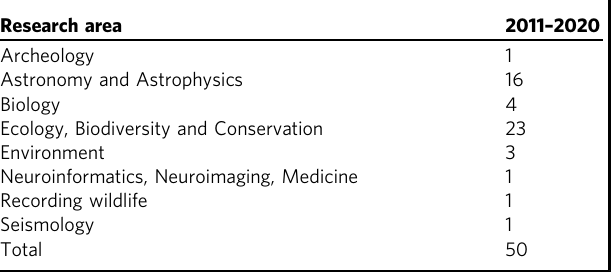
Table 4 Distribution of the reviewed papers per research area from 2011 to 2020.